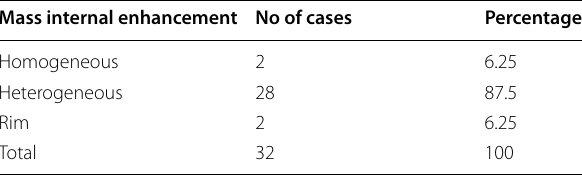
Table 5 Mass enhancement pattern by CEDM